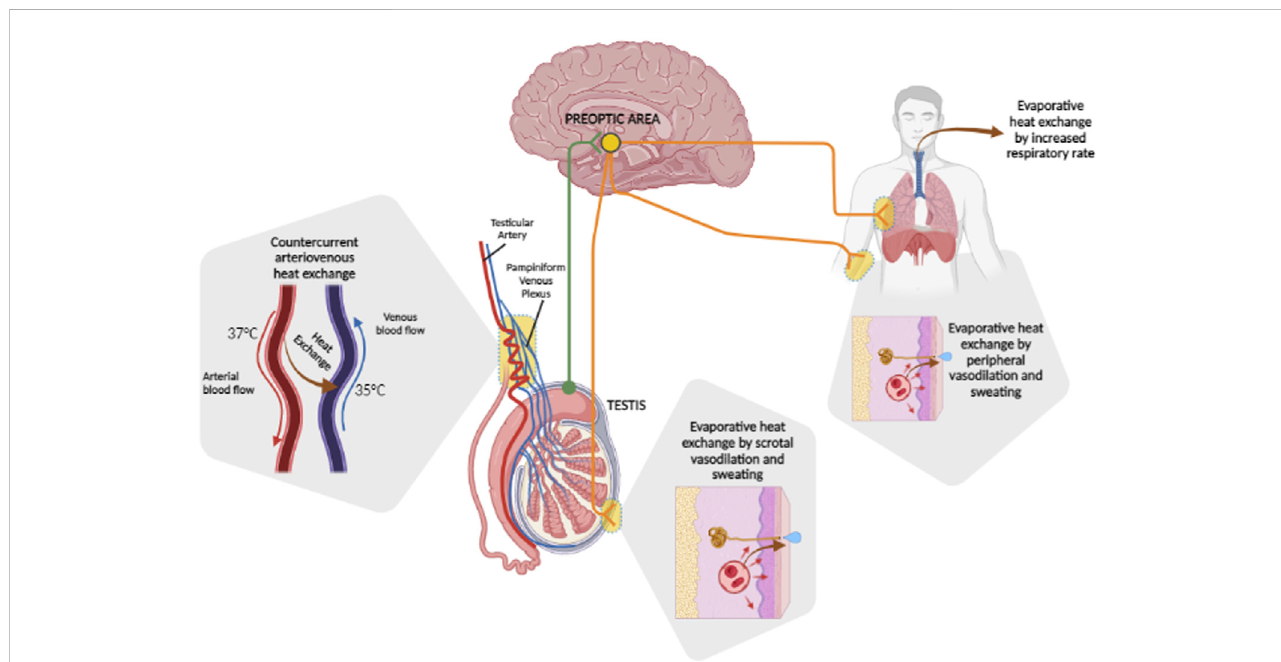
FIGURE 1 Heat dissipation mechanisms of the testis. Basal testis temperature is maintained at 2 ° C – 4 ° C below the core body temperature by countercurrent arteriovenous heat exchange between the incoming testicular artery, which carries blood at ~37 ° C, and the outgoing pampiniform plexus, carrying blood at ~35 ° C.Variationsoftissuetemperaturearelocallyperceivedbynerveafferentsofthepreopticareaofthebrain(green fi bers)which,dependingontheentityof heat challenge, integrates thermoregulatory response (orange fi bers). These may rely on local evaporative heat exchange by scrotal vasodilation and sweating, which can be extended systemically, eventually involving evaporative heat exchange by an increased respiratory